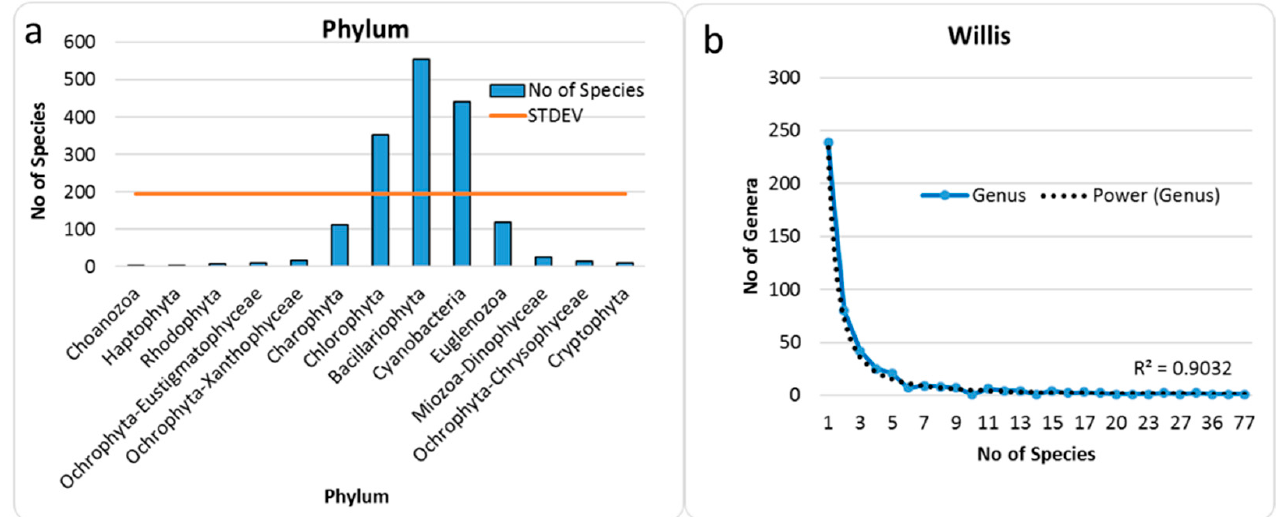
Figure 1. Distribution of species richness of algae and cyanobacteria of Israel over taxonomic phyla with STDEV as standard deviation line ( a ), and in the Willis curve as number of genera over species number ( b ).